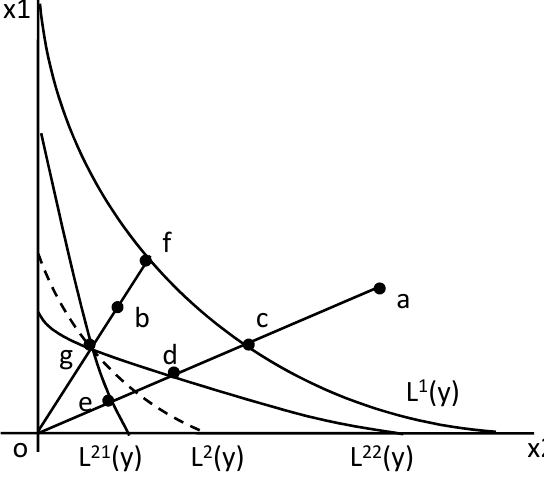
Figure 3. Output-biased technical change.